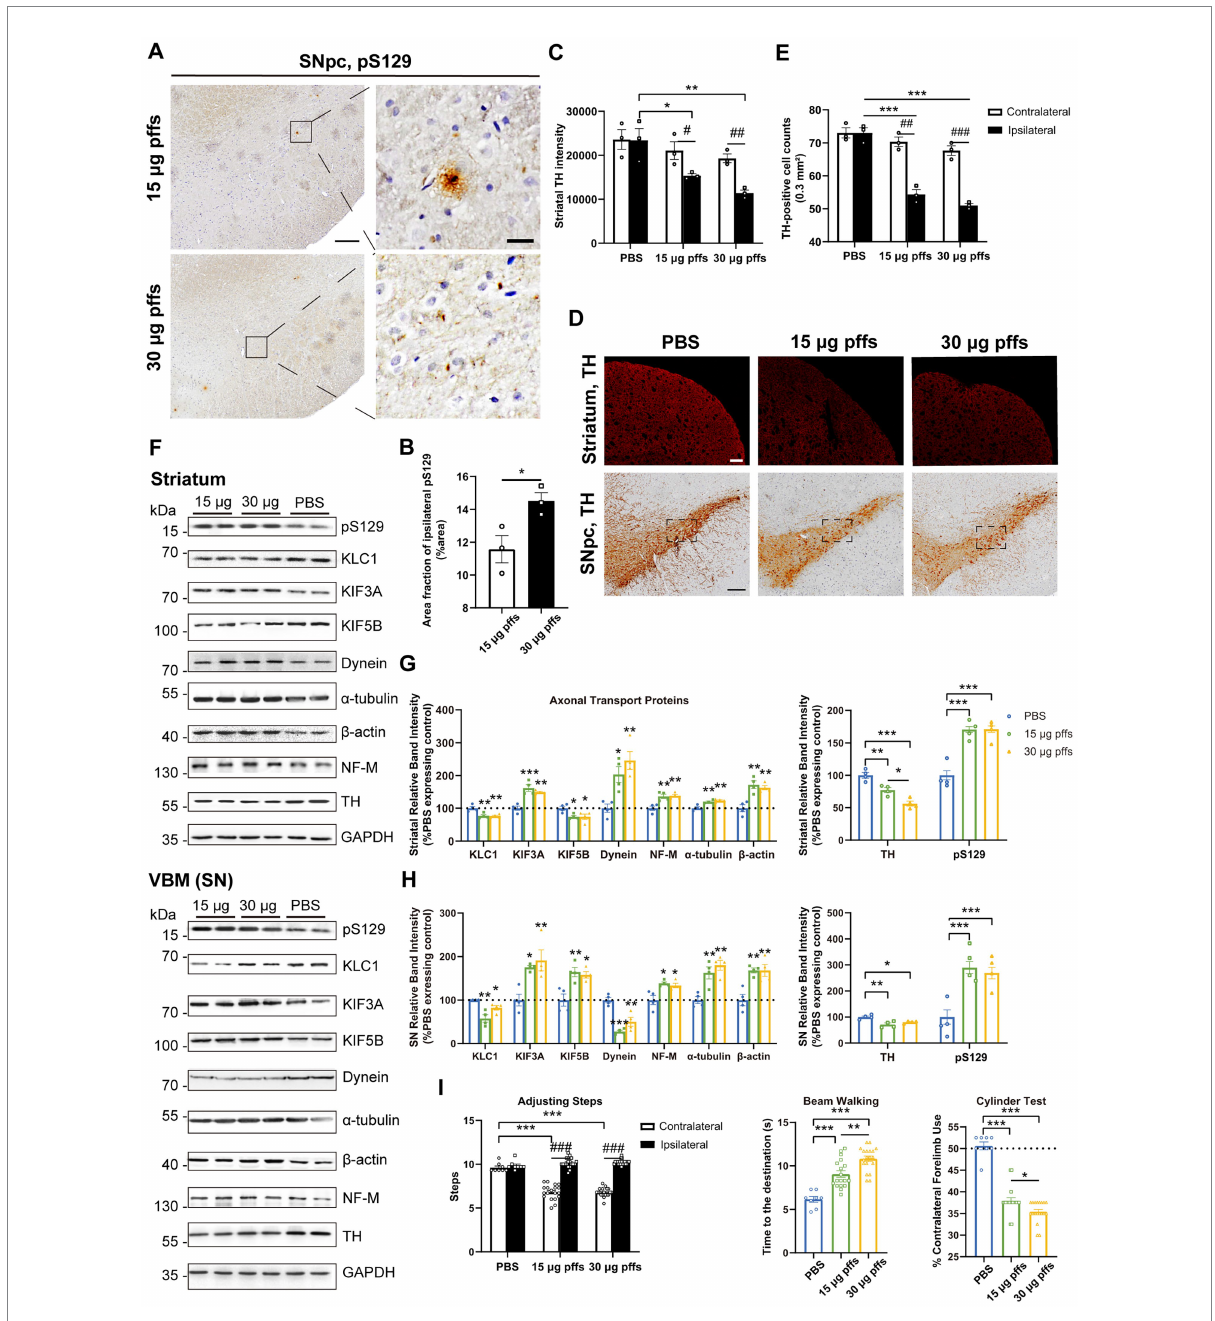
FIGURE 6 Evaluation of the nigrostriatal pathway at 3 months post injection. (A) α -Syn pS129 expression in the SNpc. Scale bar = 200 μ m (left) and 20 μ m (right). (B) The area fractions of ipsilateral α -Syn pS129 were quantified by ImageJ ( n = 3; * p < 0.05). (C) Fluorescent densitometry of striatal TH ( n = 3; * p < 0.05, ** p < 0.01; # p < 0.05, ## p < 0.01). (D) TH-positive cells in the nigrostriatal regions. Scale bar = 200 μ m. (E) TH-positive cells in the SNpc were quantified by counting ( n = 3; *** p < 0.001; ## p < 0.01, ### p < 0.001). (F) Representative western blot of nigrostriatal changes. (G,H) Quantitative analysis of the afore-mentioned proteins (* p < 0.05, ** p < 0.01, *** p < 0.001; n = 4). (I) Evaluation of behavioral changes ( n = 18; * p < 0.05, ** p < 0.01, *** p < 0.001; ### p < 0.001). All of the data was shown as means ±